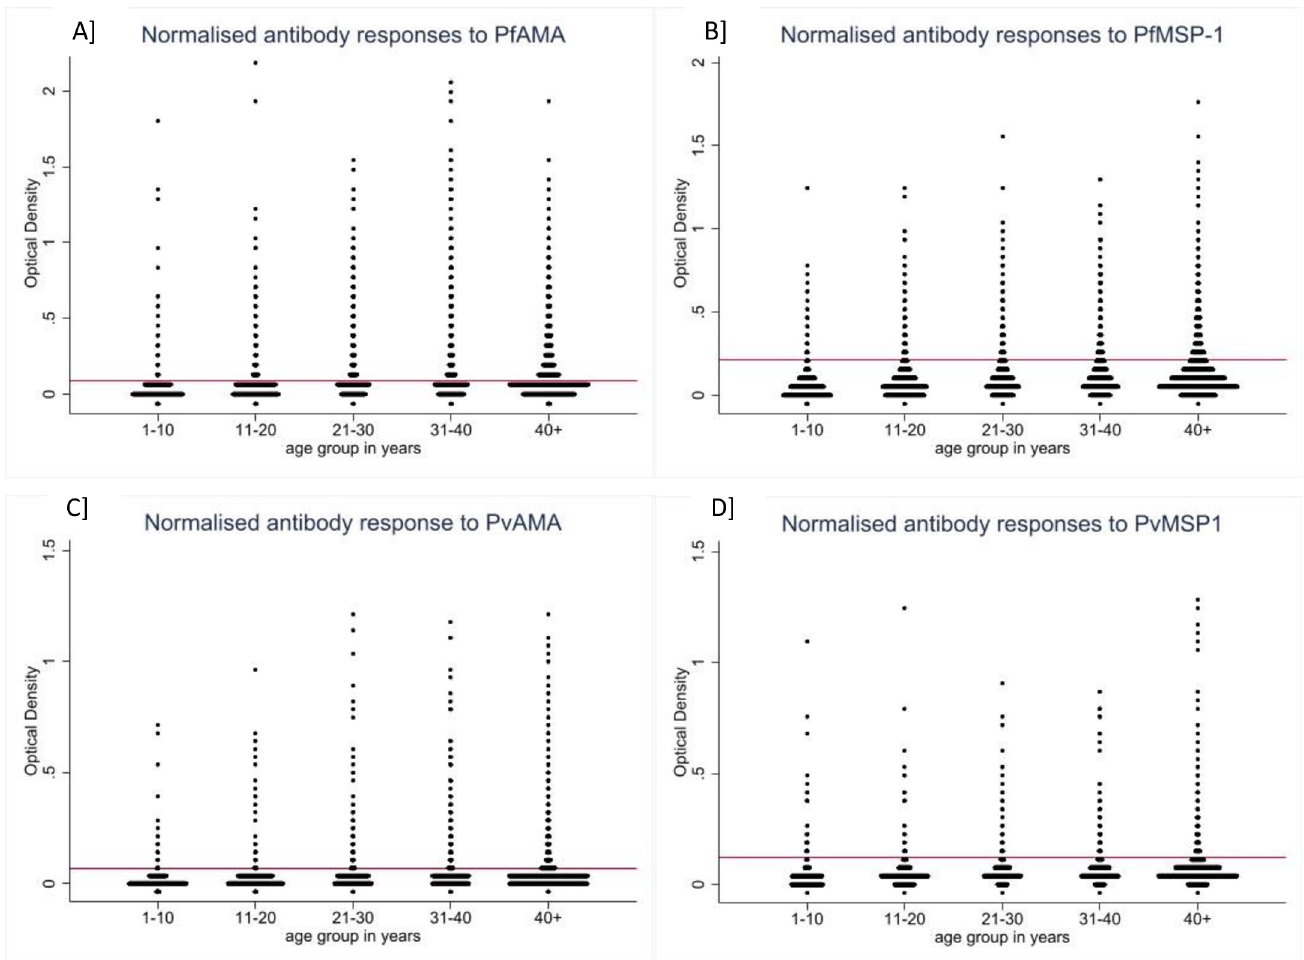
Fig 3. Normalised age-stratified antibody responses to P . falciparum antigens A] PfAMA, B] PfMSP-1, and P . vivax antigens C] PvAMA, D] PvMSP-1. Horizontal red lines represent antigen-specific cut-off valus.